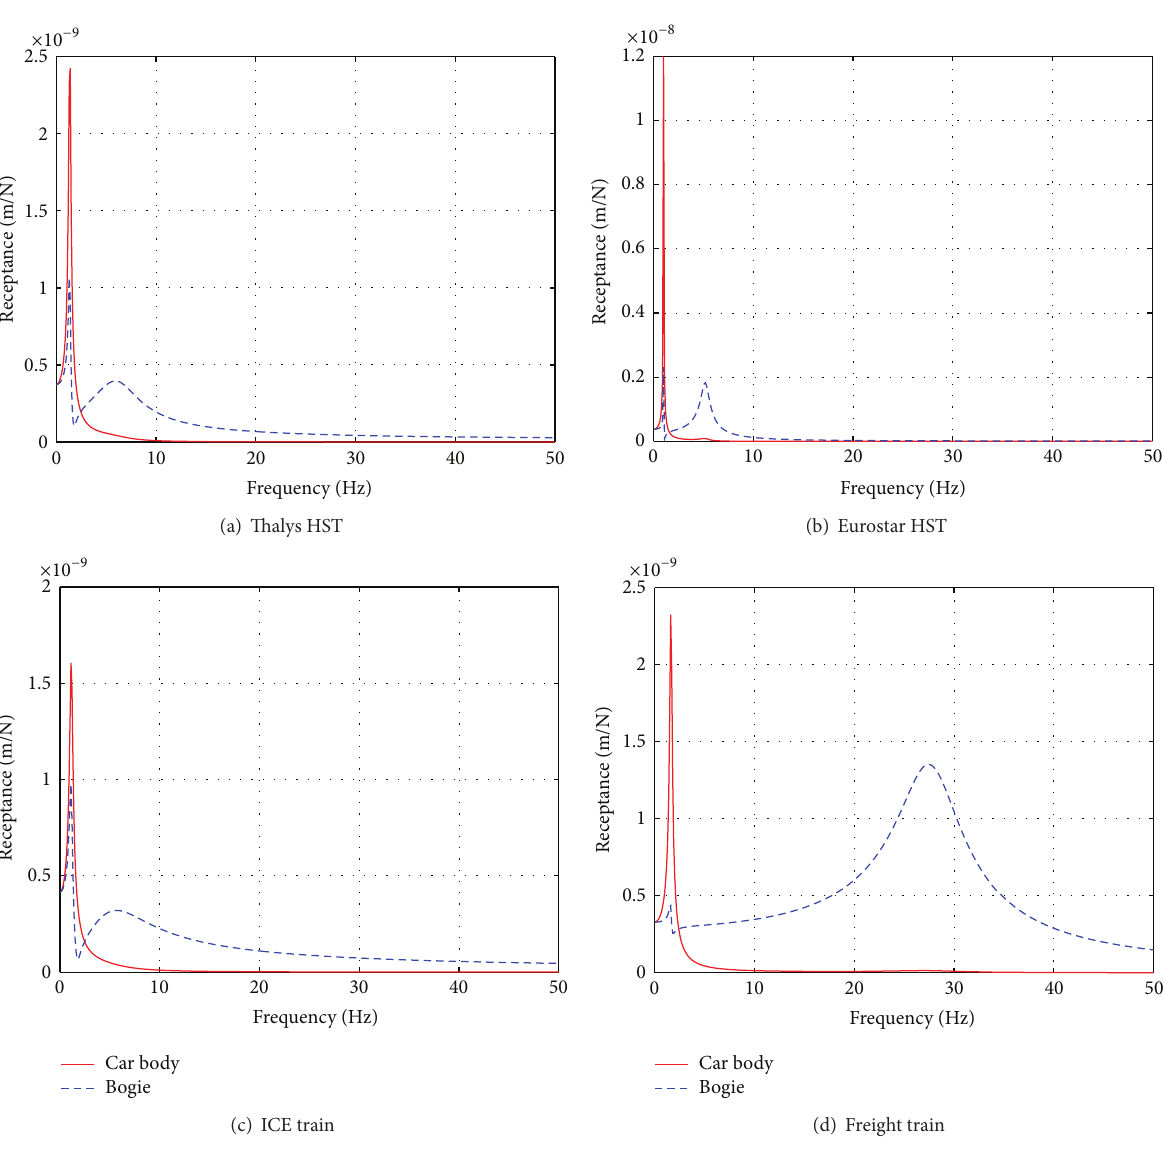
Figure 5: Frequency response functions of the studied trains (vertical excitation at front wheel and vertical displacements of car body and